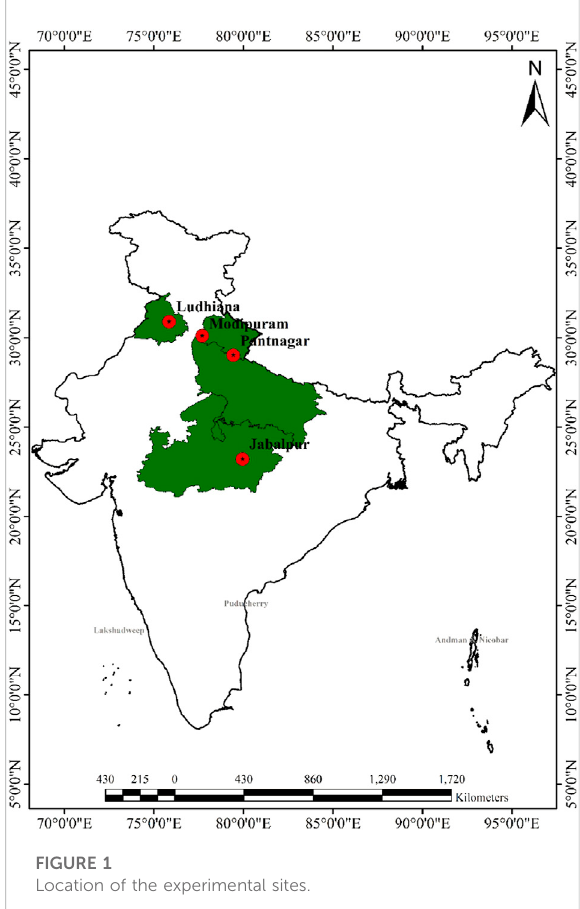
FIGURE 1 Location of the experimental